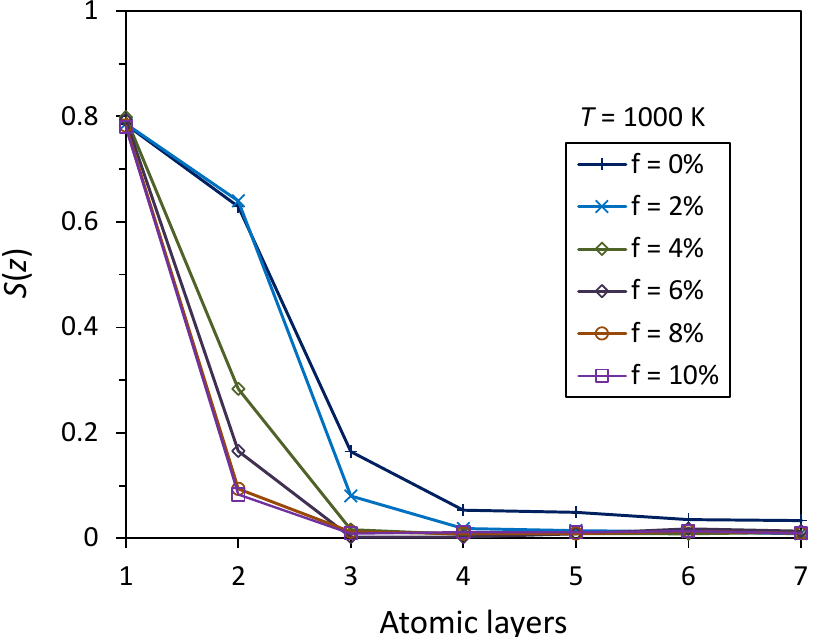
Figure 6. Prenucleation in systems with a small positive lattice misfit [24]. In-plane order parameter, S ( z ), as functions of lattice misfit and atomic layers away from the interface for the systems with small positive misfit, equilibrated at 1000 K. Generally, the in-plane atomic ordering degrades with increasing misfit. It is interesting to note that the S ( z ) of L1 is nearly the same (about 0.8) for all of the systems with varied misfit.